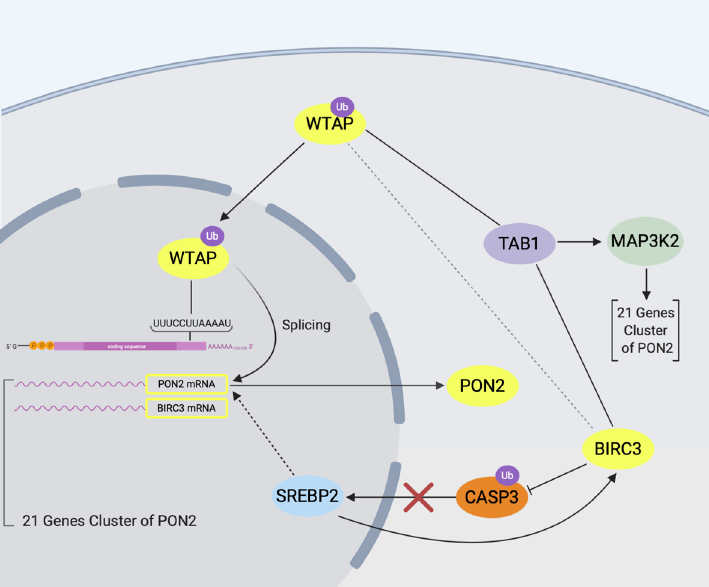
Figure 5. PON2 regulation model. In this model the main actors are PON2, WTAP, and BIRC3. WTAP binds the conserved dodecameric sequence (UUUCCUUAAAAU) found in 3 (cid:48) UTR regions of PON2, BIRC3, and other genes of a cluster identified by a meta-analysis approach. Through this binding WTAP regulates PON2 and BIRC3 (their expression increases with WTAP depletion). BIRC3 is an E3 ubiquitin ligase decreasing PON2 mRNA and protein expression [23], but not its ubiquitination. We suggest that the negative modulation of BIRC3 on PON2 is mediated by the ubiquitination of an unknown factor, which we think could be WTAP. In addition, BIRC3 modulates PON2 splicing (different expression of PON2 isoforms with BIRC3 depletion), and since WTAP is a splicing regulator this observation strengthens the hypothesis that WTAP is regulating PON2, after being ubiquitinated by BIRC3. We hypothesize also the involvement of the BIRC3-CASP3-SREBP2 pathway as a way of BIRC3 to modulate PON2. The depletion of BIRC3 increased WTAP expression suggesting a new link of interactions into the model. BIRC3 and WTAP both interact with TAB1, a kinase able to bind and activate MAP3K2, another protein present in the PON2 genes